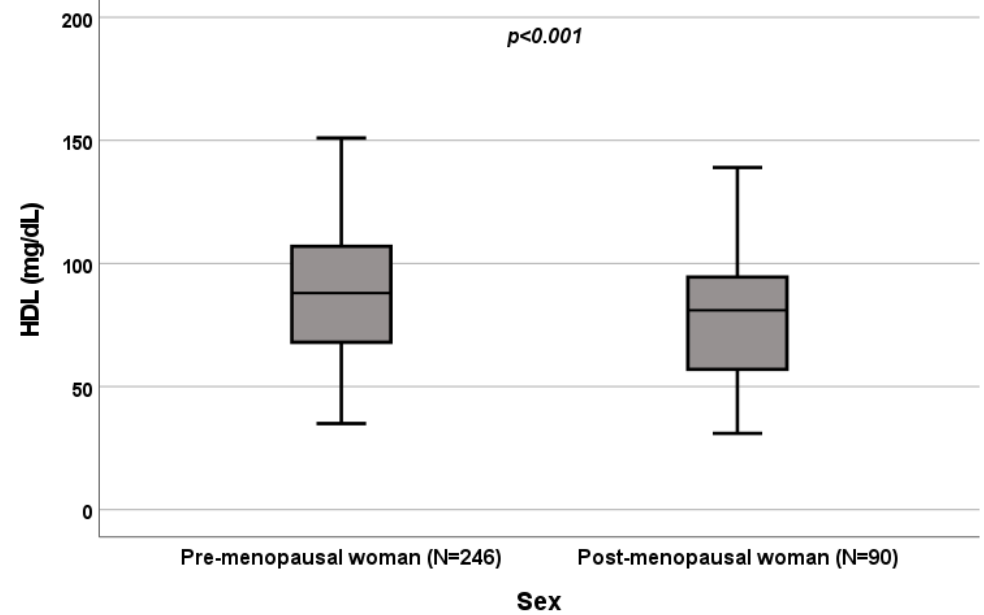
Figure 5. Influence of sex on HDL levels (mg/dL). Box plot of sex ’s influence on HDL levels (mg/dL): The black lines in the boxes show the interquartile ranges (IQRs): quartile 1, median values and quartile 3; the open dots and stars describe the outlier values. The P -value is shown.